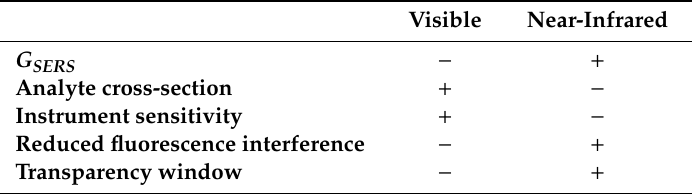
Table 5. The symbols + and − indicate, as a rule of thumb, the spectral region in which the factors listed in the first column are more or less favored. Concerning the instrument sensitivity, the gratings and optics can be optimized for working in di ff erent spectral regions; the detectors can cover the visible region up to approximately 1100 nm (silicon-based CCDs) or regions further to the red (InGaAs based arrays). Considering that silicon detectors are more common and less expensive than their InGaAs counterparts, the “Instrument sensitivity” has been assigned as more favorable in the visible region. Visible Near-Infrared G SERS Analyte cross-section Reduced fluorescence interference